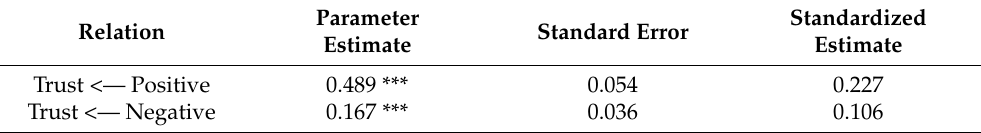
Table 8. Regression results: parameter estimates, standard errors, and standardized